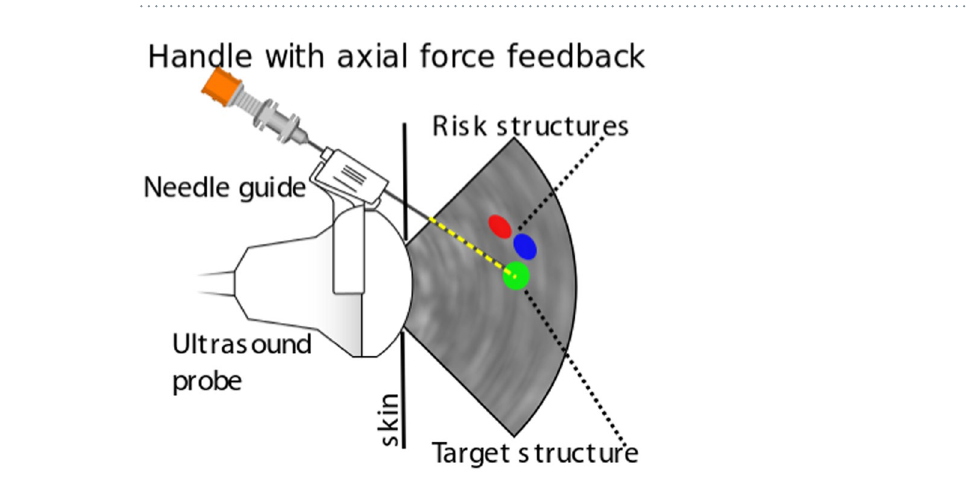
Figure 2. Schematic overview of ultrasound (US) guided needle insertion into the right hepatic duct (RHD): A US probe is put on the skin and captures a dilated hepatic duct (target structure). The needle is guided on a rail at the side of the probe. Puncturing of risk structures such as blood vessels should be